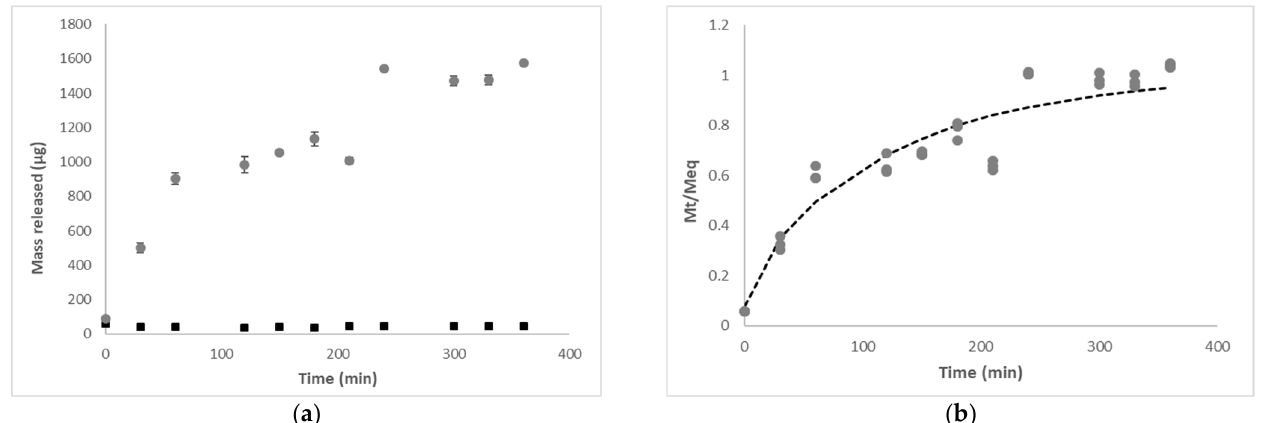
Figure 3. Profile of phenolic compounds release from alginate particles (T2—0.5 mol·L − 1 formulation, 1.5% alginate and 0.5 mol·L − 1 CaCl 2 ): ( a ) mass of phenolic compounds released at pH 1.5 ( ■ ) and pH 7.2 ( ● ); ( b ) experimental data of phenolic compounds release at pH 7.2 ( ● ) and description of linear superimposition model ( i = 1) (--).